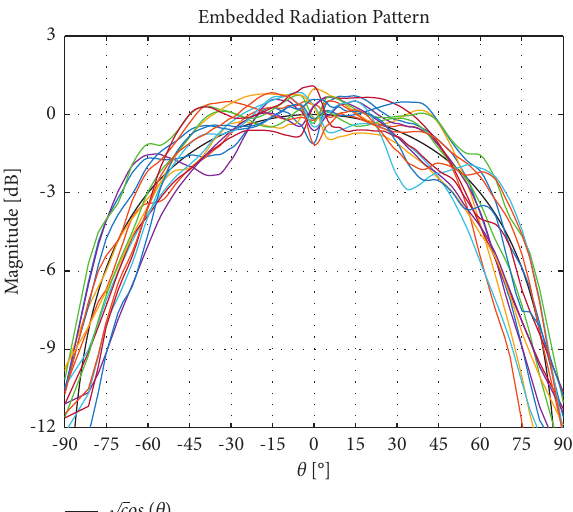
Figure 10: Normalized embedded element patterns of the designed 4 × 4 array measured in the anechoic test facility at